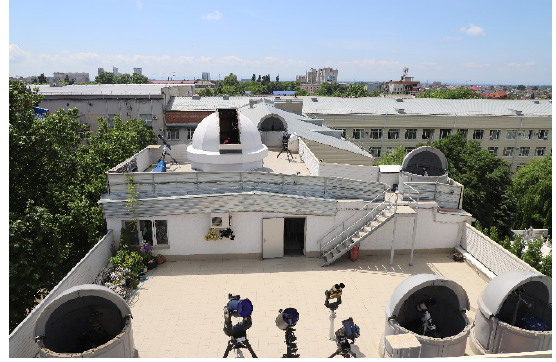
Figure 10. The Kuban State University Observatory.